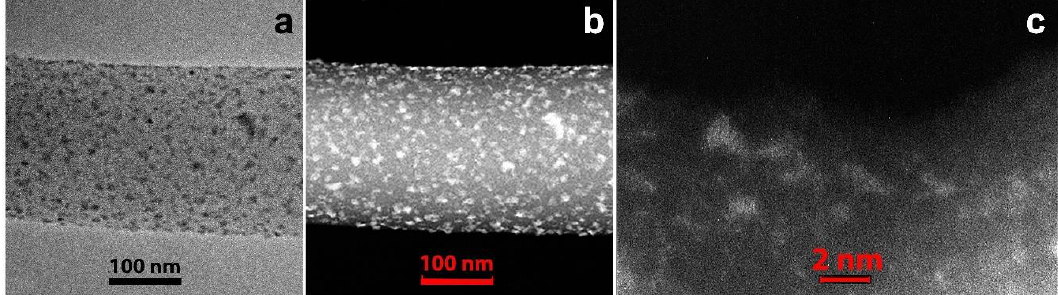
Figure 1. Pyrolyzed CNF / Zr / Ni / Gd composite 1: ( a ) bright field transmission electron microscopy (BF TEM) image; ( b ) scanning transmission electron microscopy with a high-angle annular dark-field detector (STEM HAADF) image; ( c ) STEM HAADF image of small particles.